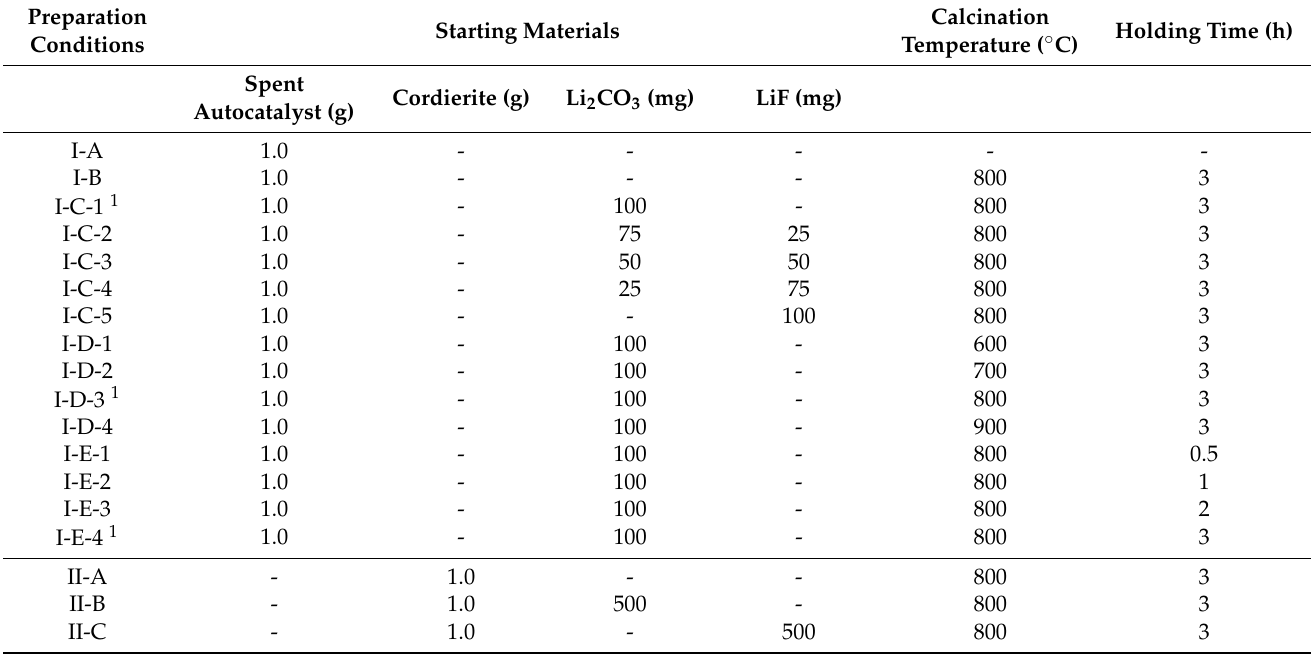
Table 2. Quantities of reagents added and subsequent calcination conditions.